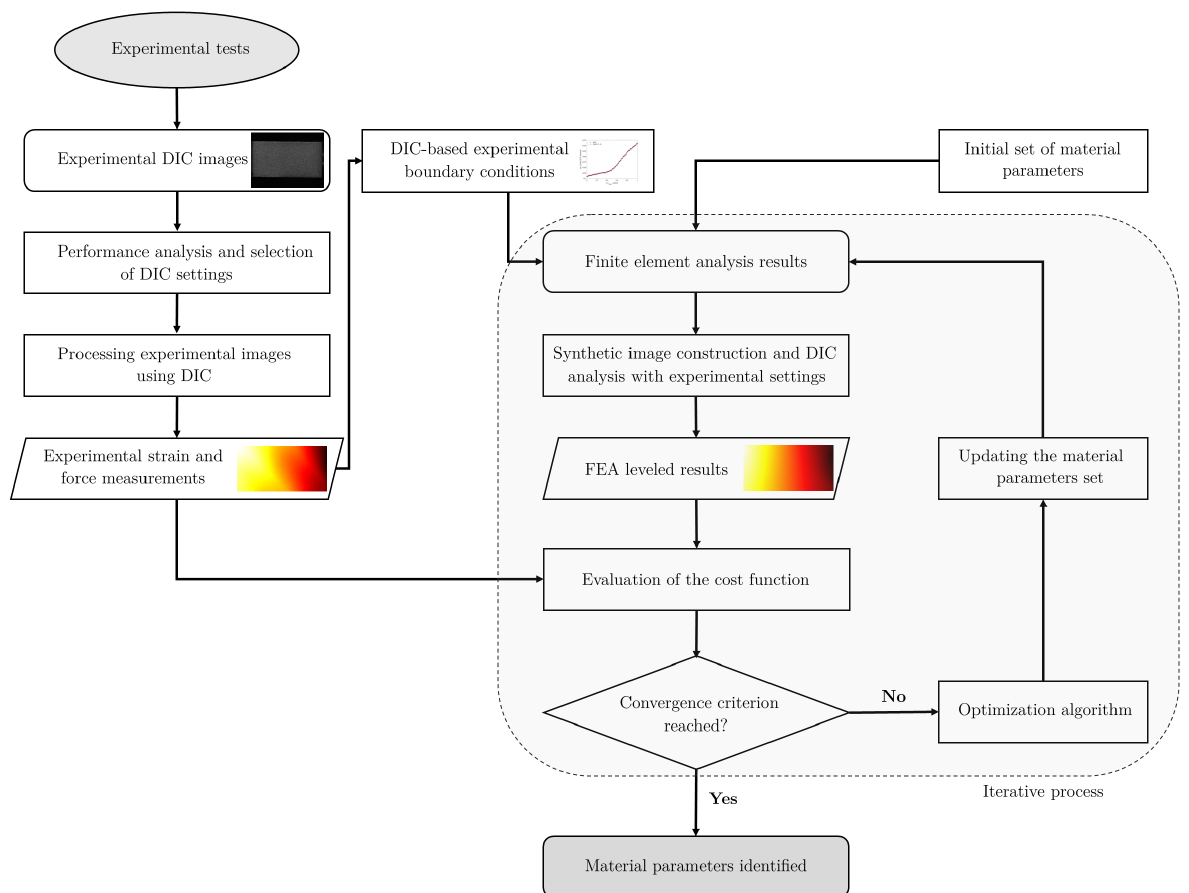
Figure 1. Flow diagram describing the material parameters identification process using